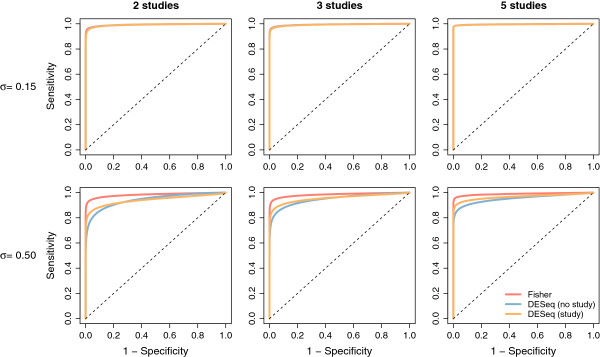
Receiver operating characteristic curves for low and high inter-study variability. Receiver Operating Characteristic (ROC) curves, averaged over 300 datasets. Each plot represents the results of a particular setting, with columns corresponding (from left to right) to simulations including 2 studies, 3 studies, and 5 studies, and rows corresponding (from top to bottom) to simulations with inter-study variability set to σ=0.15 and σ=0.50 (small to large inter-study variability). Within each plot: Fisher (red lines), global analysis with no fixed study effect (DESeq (no study), blue lines), and global analysis with a fixed study effect (DESeq (study), orange lines). The dotted black line represents the diagonal.